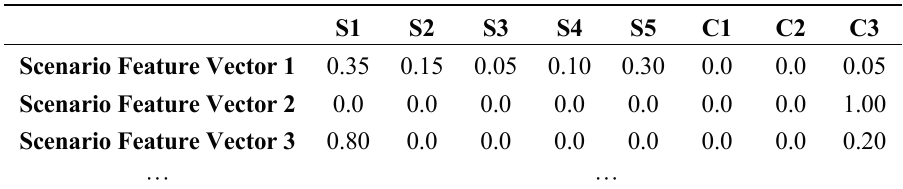
Table 4. Training data example.